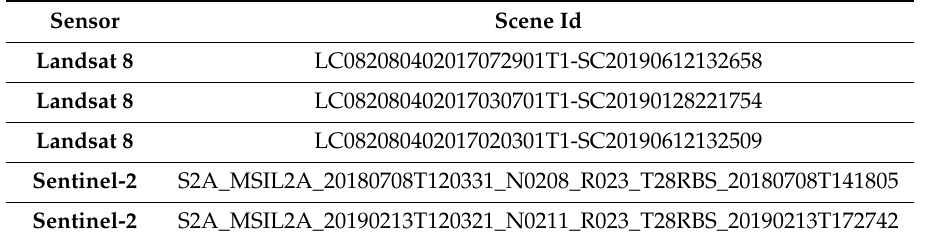
Table A1. Satellite images used in the study.